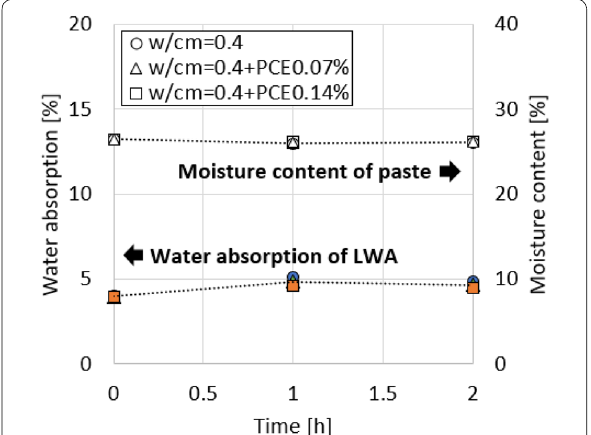
Fig. 5 Effect of chemical